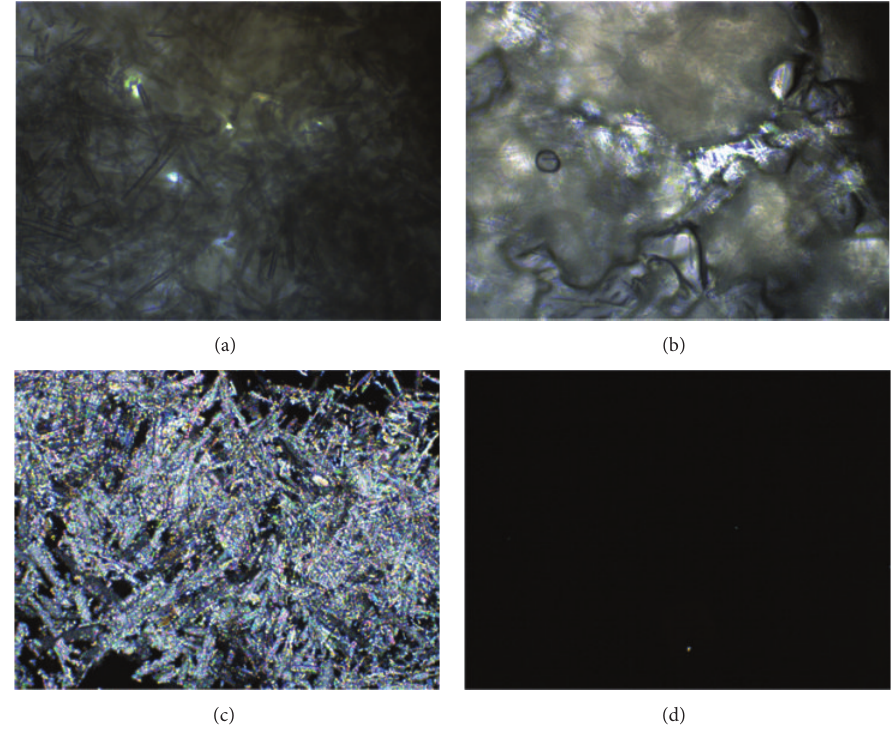
Figure 3: POM images of TMBPDE at different temperatures (200x): (a) 100 ∘ C; (b) 107 ∘ C; (c) 110 ∘ C; (d) 118 ∘ C.